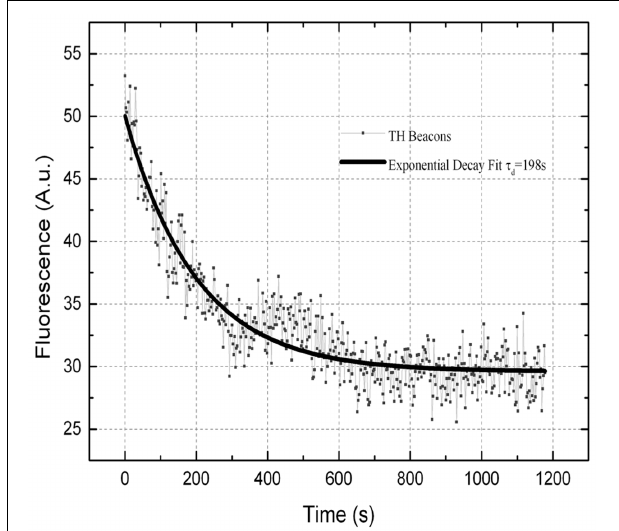
FIGURE 2 | Fluorescence emission decay as a function of time for a representative HeLa cell after the second treatment with SLO. The resulting time constant is τ exp = 198s.